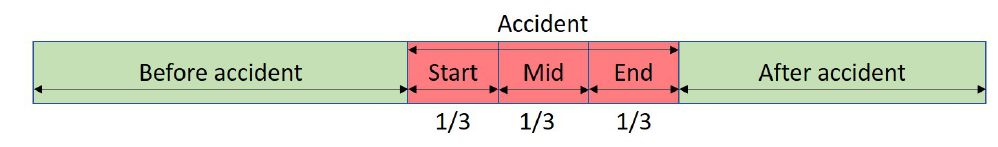
Figure 6. Temporal partition of the video. Dividing the accident part in three pieces of same length to evaluate the results by